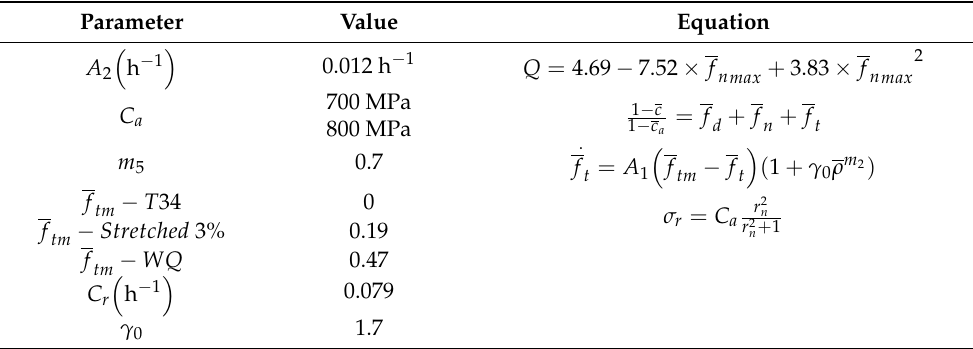
Table 4. Material constants and equations modified in the revised model